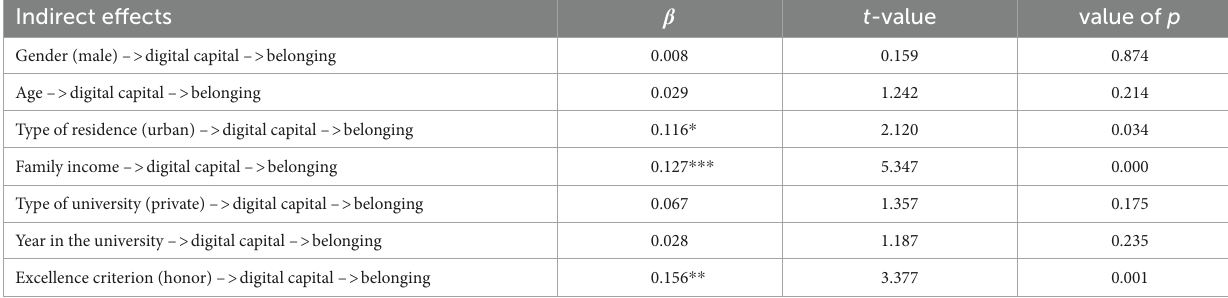
TABLE 8 Indirect effects on